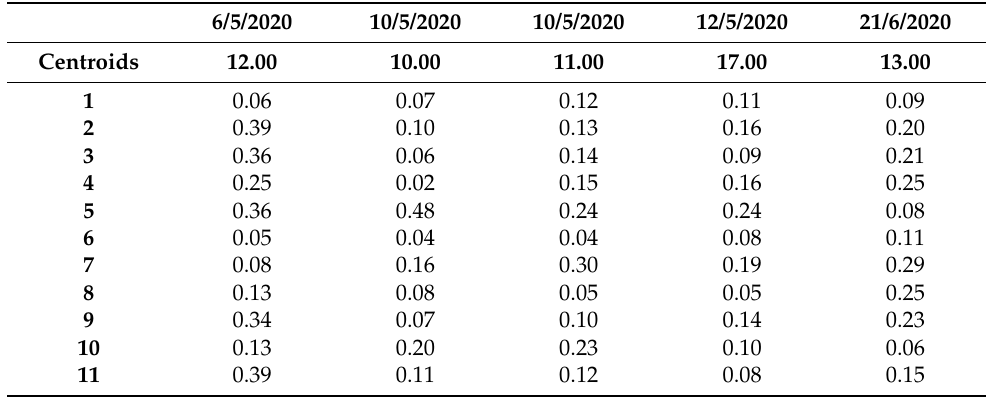
Table A5. Calculated centroid distance errors (m). The largest and smallest distance errors of six polygons have been calculated on 06/05/20, five on 10/05/20 at 10.00, four on 10/05/20 at 11.00, two on 12/05/20, and five on